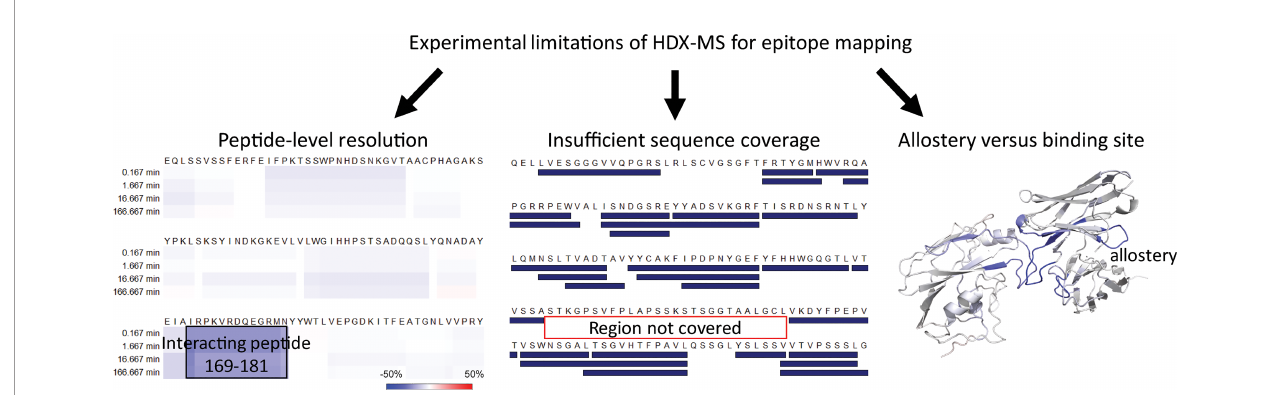
FIGURE 2 | Experimental limitations when using HDX-MS for epitope